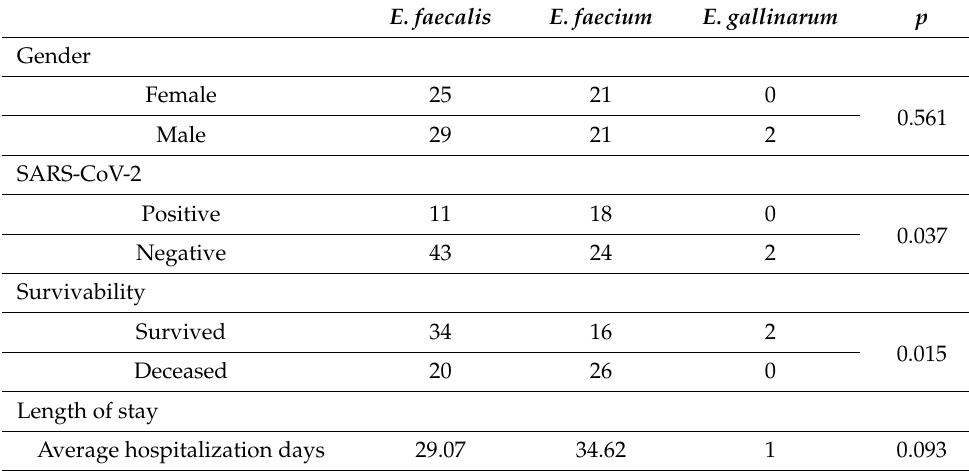
Table 1. Analysis of gender, SARS-CoV-2 infection, survivability, and length of stay among patients with E. faecalis and E. faecium .